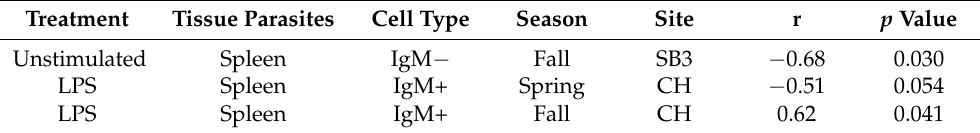
Table 3. Correlations between tissue parasites in spleen and lymphocyte mitogenesis for smallmouth bass ( Micropterus dolomieu ) collected from the Cheat River (CH) and South Branch Moorefield (SB3) sites. No significant correlations were observed at the South Branch Petersburg (SB1) site.